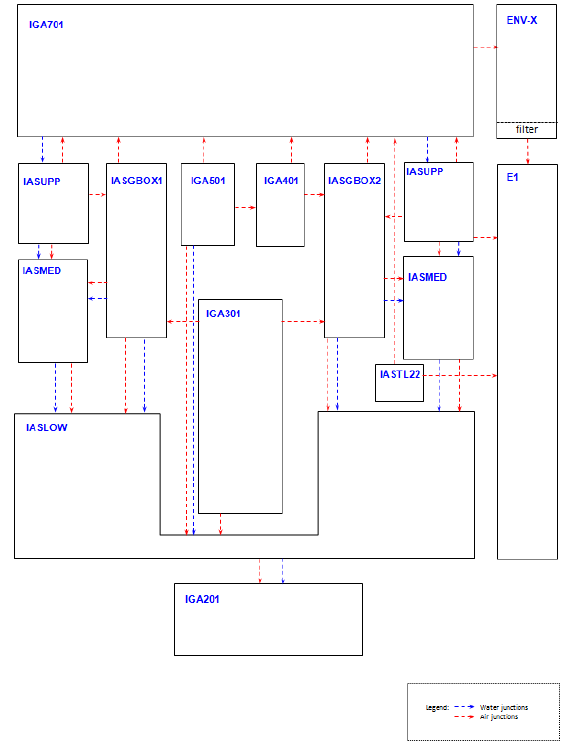
Figure 2. Iodine compartment discretization of WWER-1000/V320 NPP